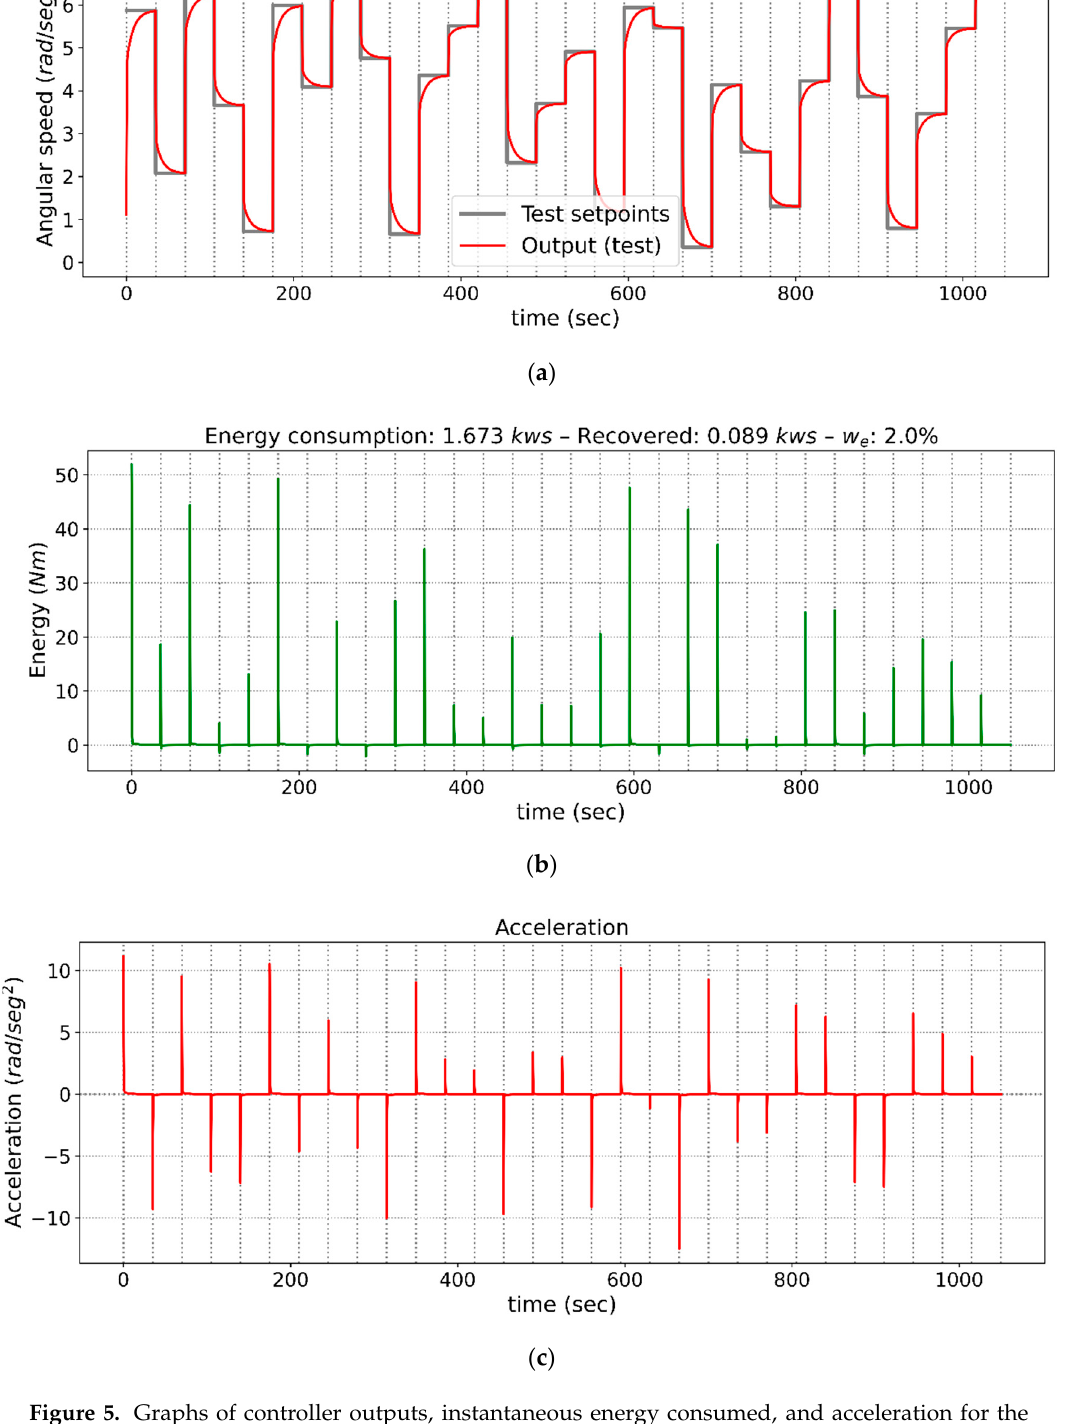
Figure 5. Graphs of controller outputs, instantaneous energy consumed, and acceleration for the adjusted PID with a 2% energy weight. ( a ) Speed response of the drive, ( b ) Energy consumption, ( c ) Acceleration of the drive.